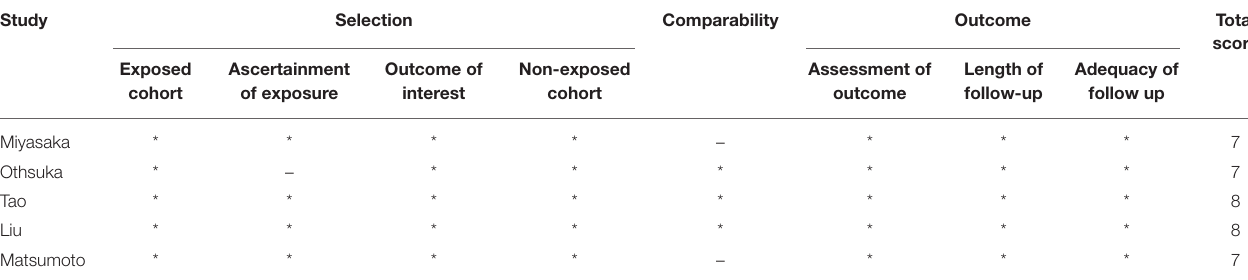
TABLE 2 | Risk of bias assessment of included cohort studies. Study